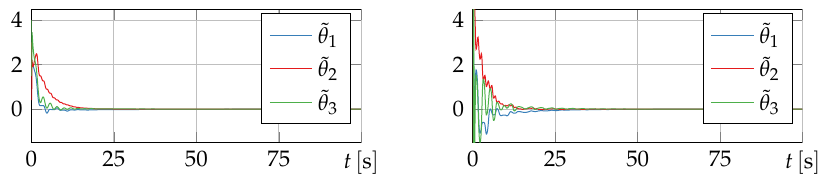
Figure 6. Results of the simulation with regressor depending on time only and different adaptation gains. ( Left ): Γ = 0.5 I , ( Right ): Γ = 5 I .